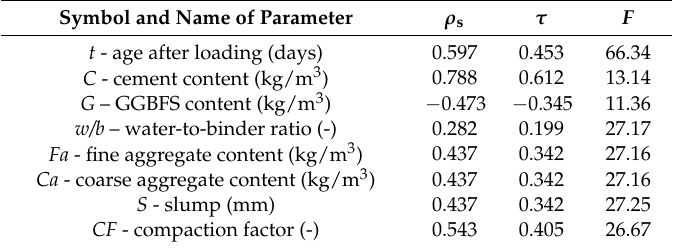
Table 6. Results of Spearmann’s ( ρ s ) and Kendall’s ( τ ) rank correlation coefficients and values of